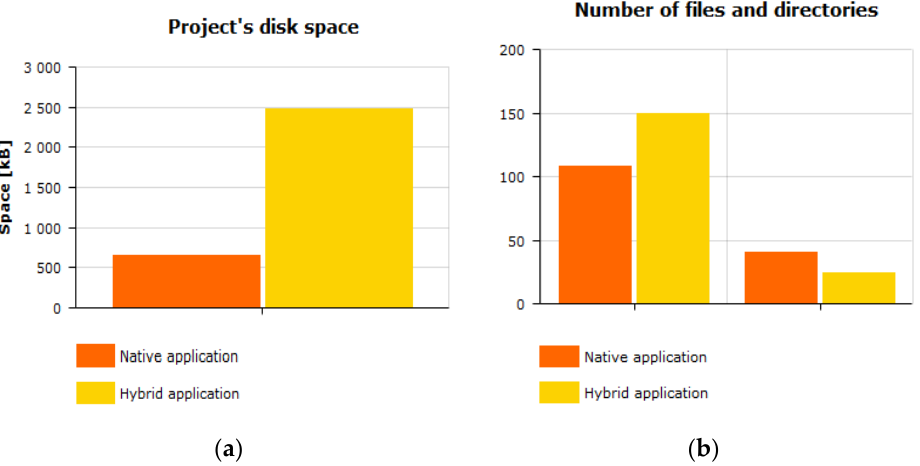
Figure 2. Project structure: ( a ) project’s disk space; ( b ) number of files and